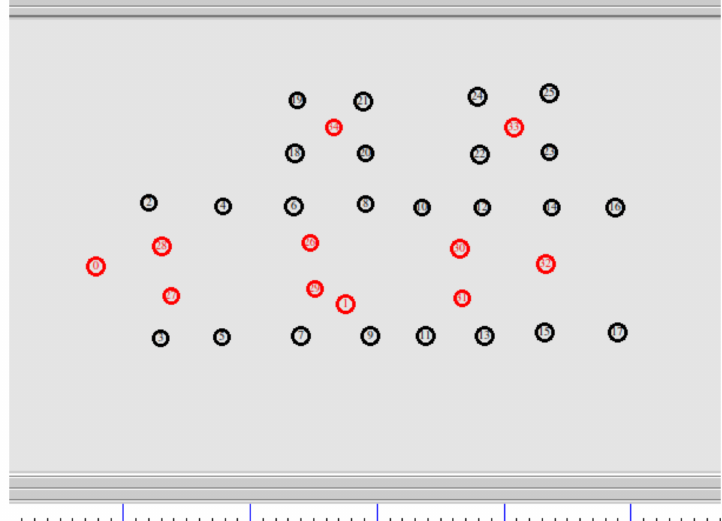
Figure 1. Initialization of flying nodes.